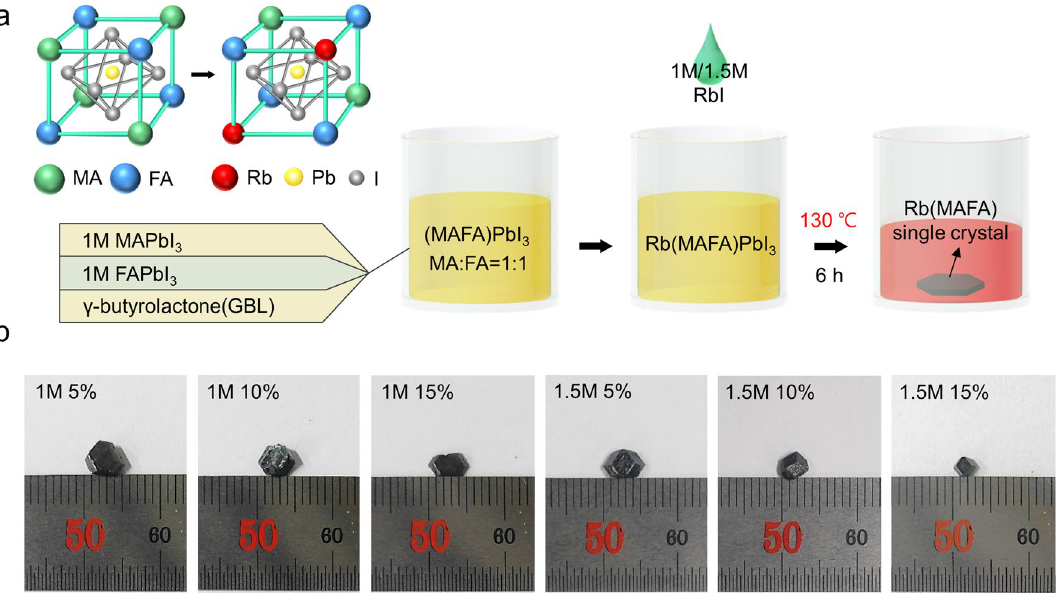
Figure 1. Synthesis of the Rb(MAFA)PbI 3 single crystals with various RbI concentrations. ( a ) Schematics of the Rb(MAFA)PbI 3 structure and the detailed ITC process. ( b ) Photographs of the Rb(MAFA)PbI 3 single crystals with various RbI